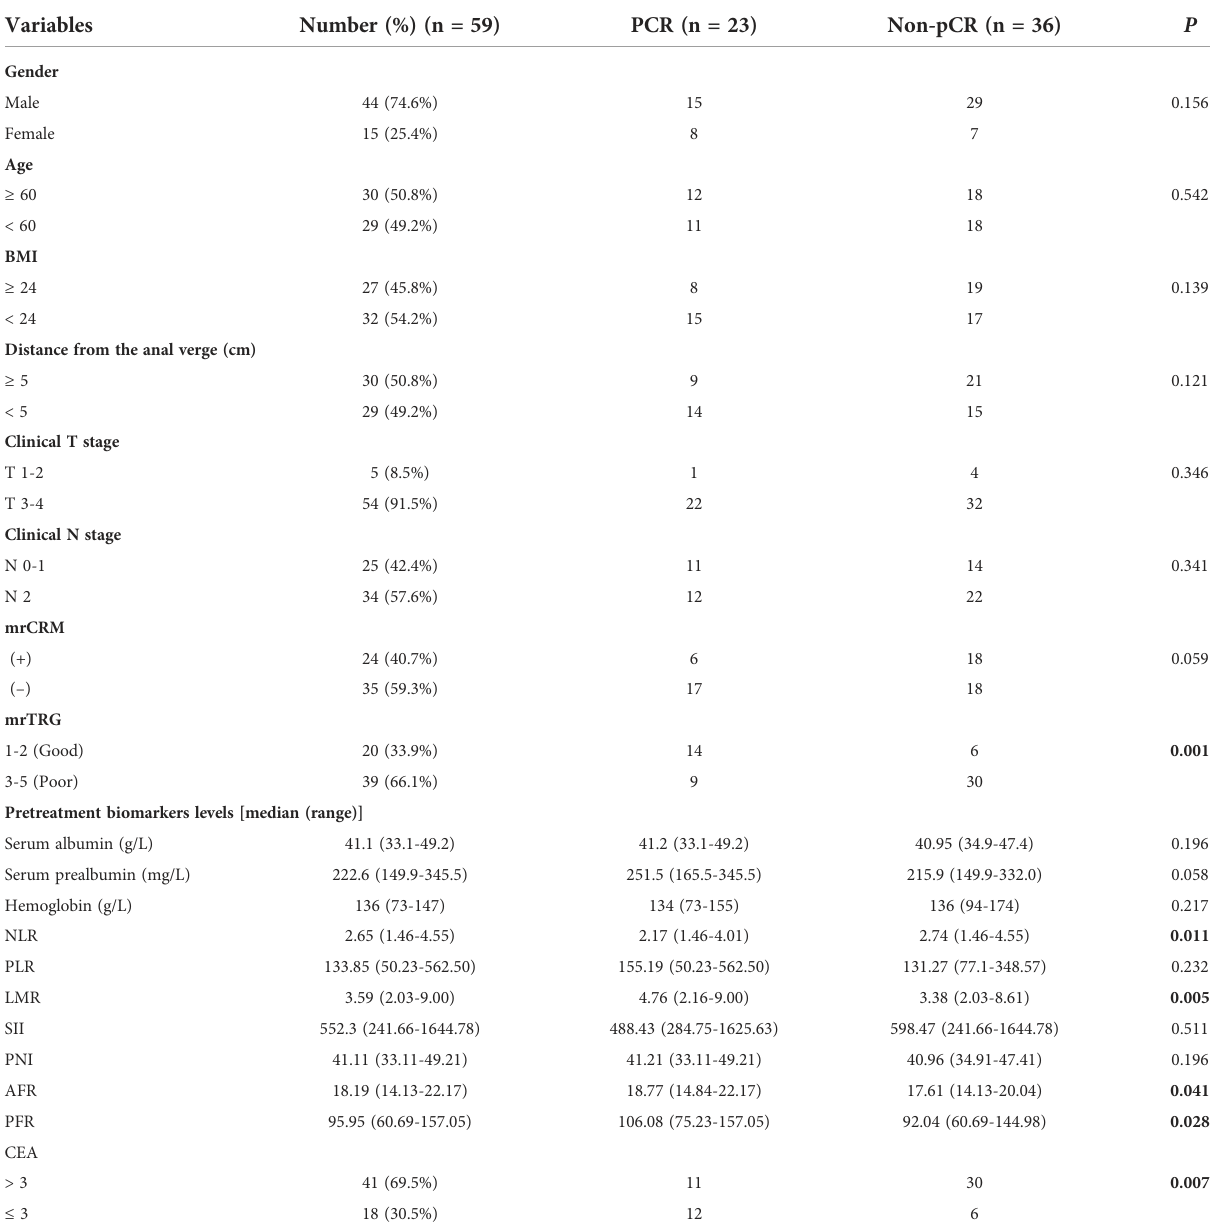
TABLE 2 Patient characteristics and response to